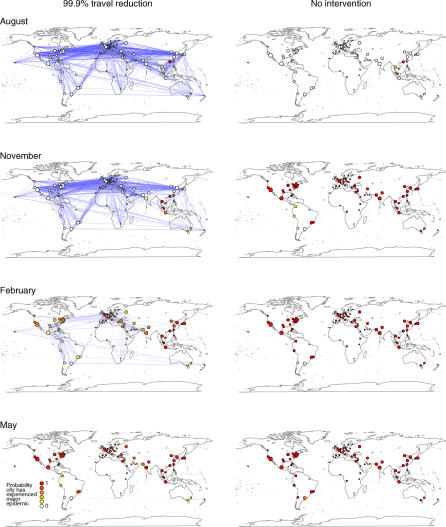
Time Course of a Pandemic with and without an Intervention to Suspend 99.9% of Air Travel from Affected CitiesMaps show the extent of epidemic spread and average impact on aviation network (taken from 100 simulation runs) 2, 5, 8, and 11 mo after the first cases on 1 June. The intervention is made after 100 cases in each city (or 1,000 cases for Hong Kong, the city of origin). Blue lines represent flights, with darker blues representing greater mean weekly passenger numbers (after accounting for interventions to suspend travel and averaging over all simulation runs). Flights are not shown when travel restrictions have been imposed by the given time in more than 95% of simulation runs. Area of circles is proportional to city population size, and shading indicates the probability of each city having experienced a major epidemic (greater than one case per 10,000 people per day) by the given time.